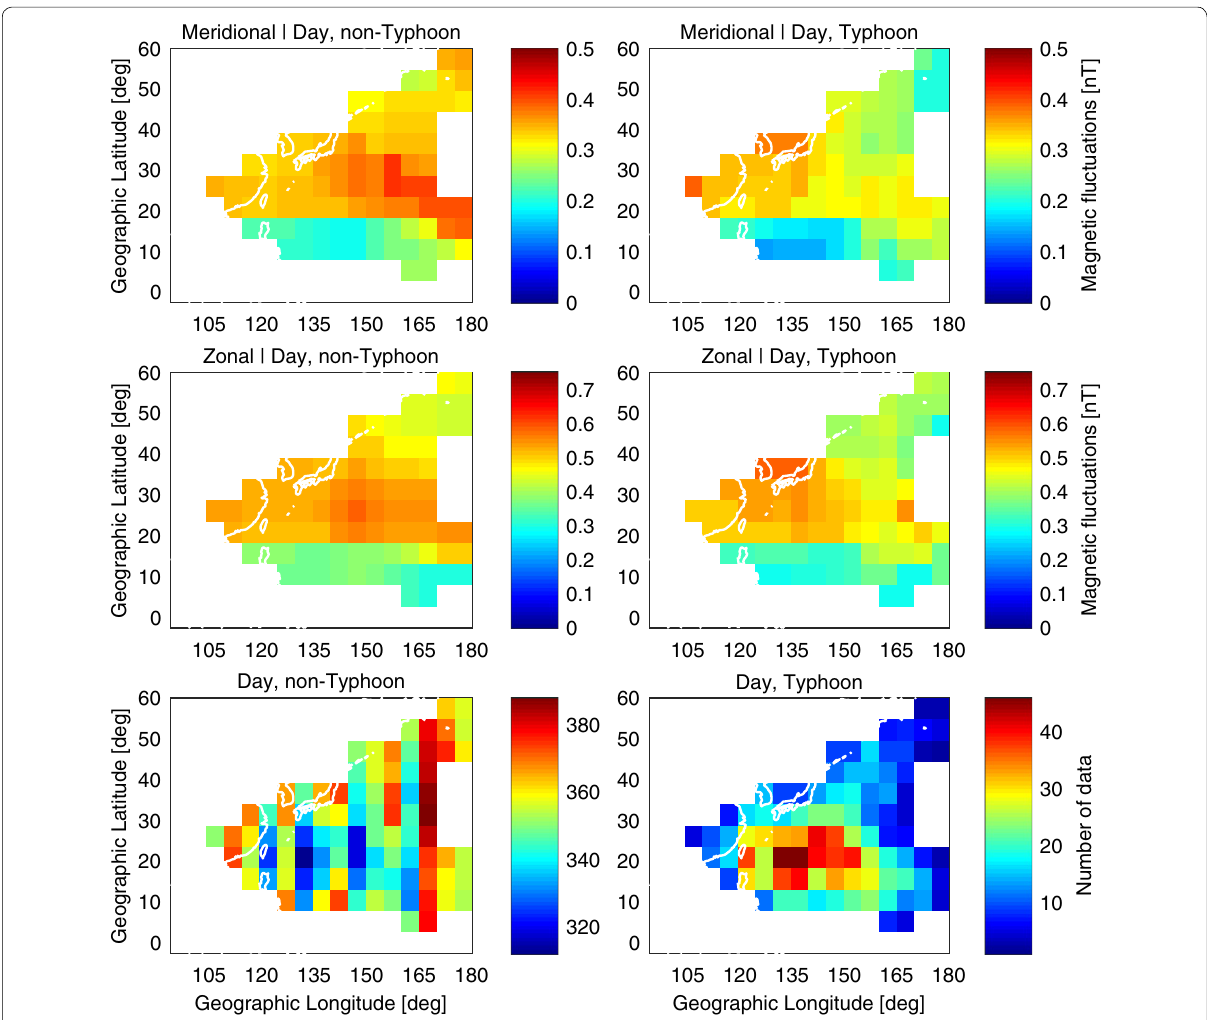
Fig. 11 Comparison of average MR amplitudes between typhoon and non-typhoon cases. The left and right panels show non-typhoon and typhoon cases on the day side sector (9–15 LT), respectively. Average amplitudes of the meridional ( top ) and zonal ( middle ) components, and num- ber of data ( bottom ) in each mesh grid are